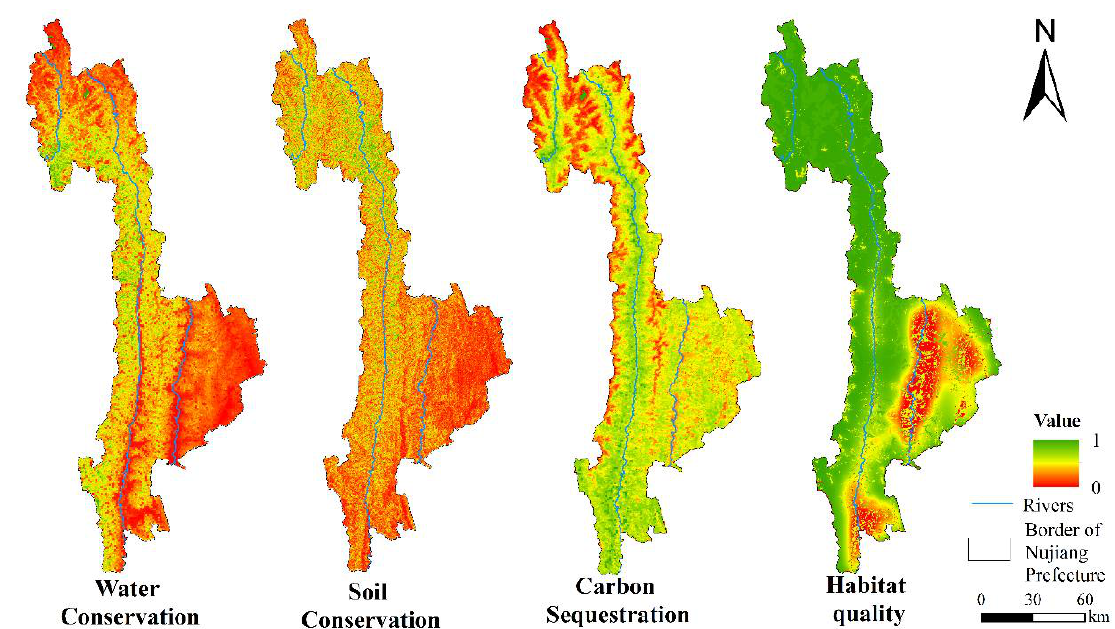
Figure 3. Evaluation of ecosystem service function in Nujiang Prefecture.